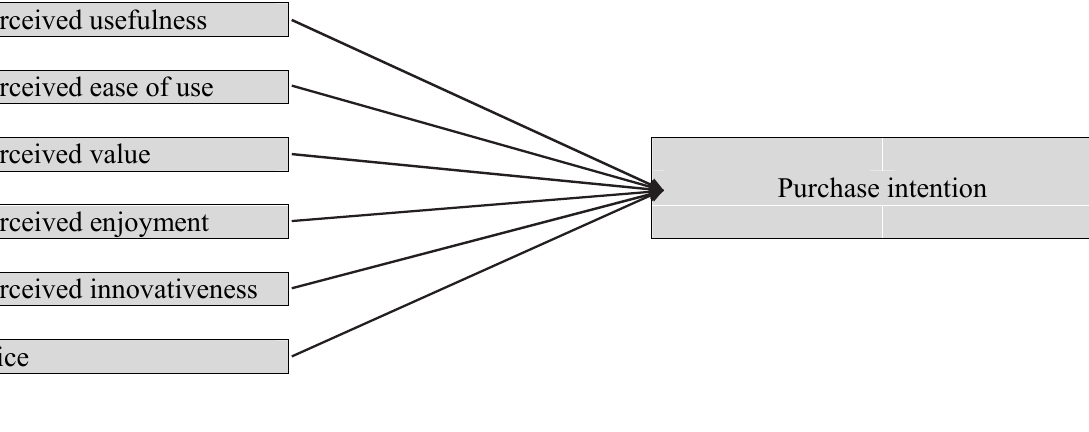
Fig. 1. Theoretical